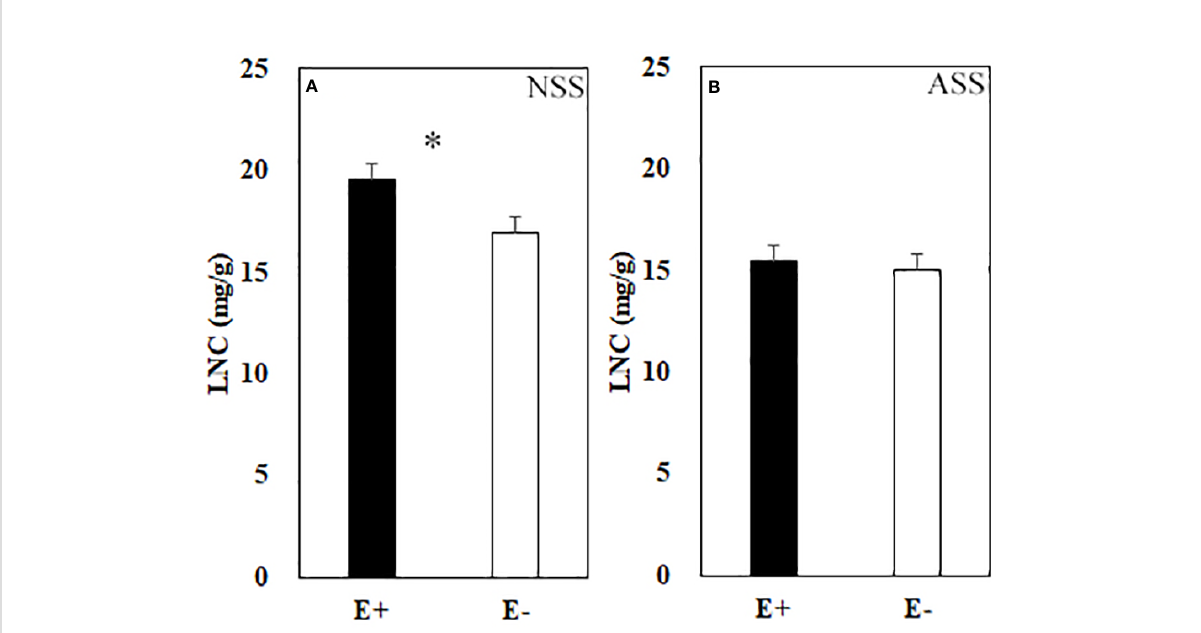
FIGURE 3 Leaf nitrogen content (LNC) of endophyte infected (E+) and uninfected (E − ) L. chinensis under neutral salt stress (A) and alkali salt stress (B) . Values are mean ± standard error. * means signi fi cant difference at p <